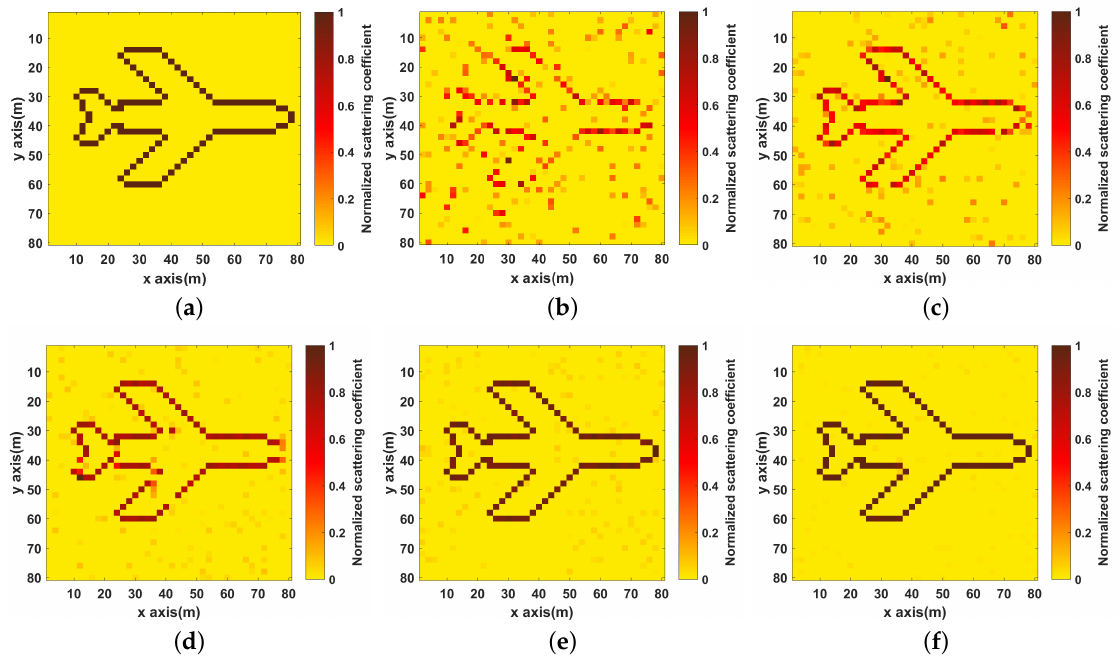
Figure 3. Imaging results ( a ) objective model; ( b ) Imaging results of OMP ; ( c – f ) Imaging results under different number of strips ( c ) no strip; ( d ) two strips; ( e ) four strips; ( f ) eight strips.